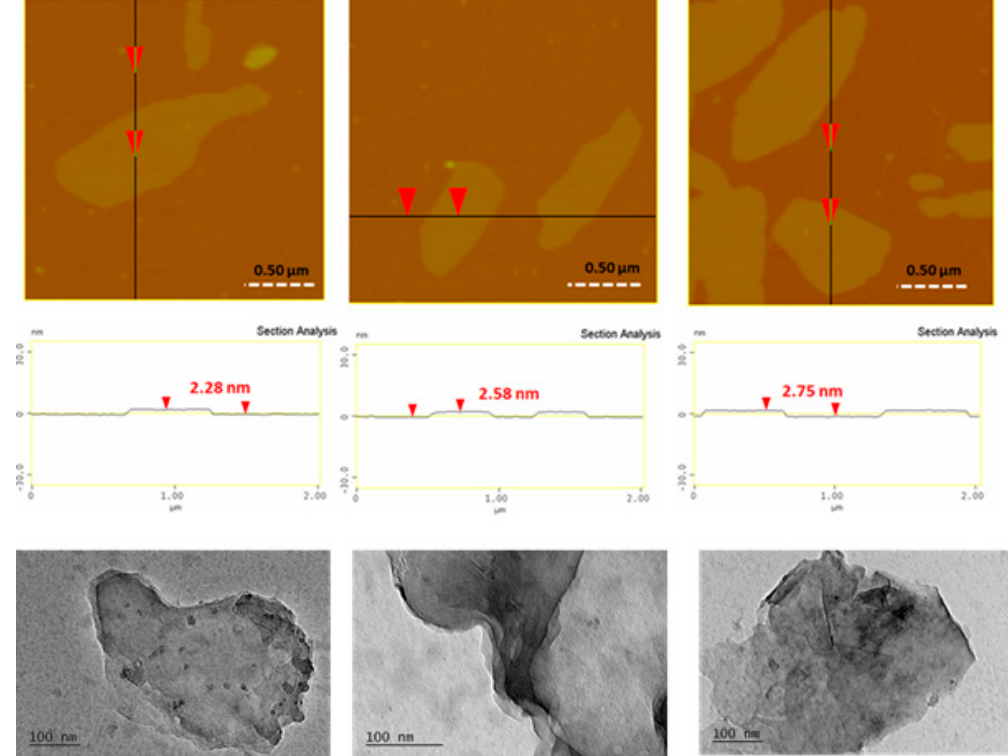
Figure 4. Top : Atomic force microscopy (AFM) images of cross-sectional analysis of selected carbon nanosheets in C-GLOVE. Bottom : Representative transmission electron microscopy (TEM) images of the sheets.